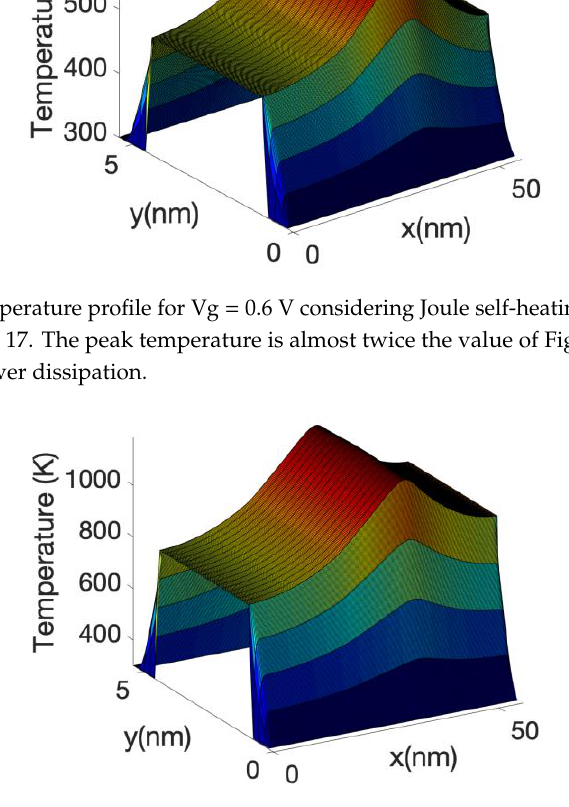
Figure 19. Lattice temperature profile for Vg = 0.6 V considering Joule heat source but no self-heating. The temperature peak is large than 1000 K. This is a substantial overestimation of lattice heating when compare with the more accurate hot electron heating of Figure 17.